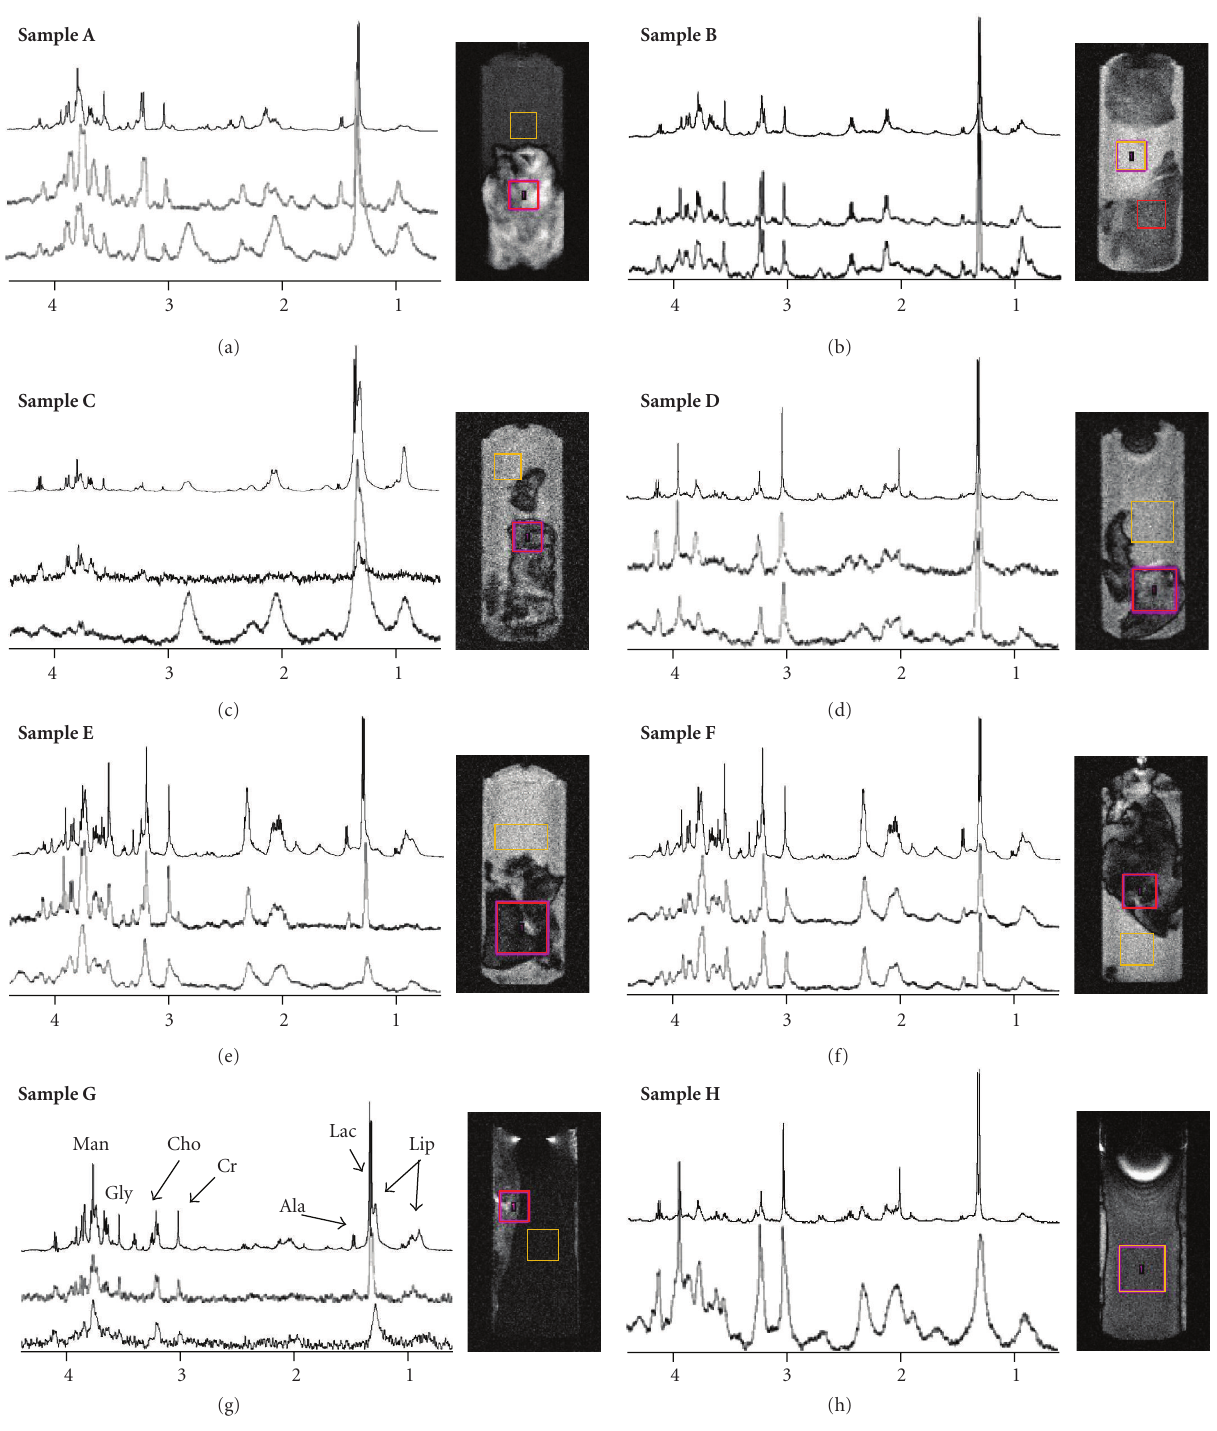
Figure 2: HRMAS CPMG (top) and MRM spectroscopy PRESS single-voxel spectra from solution (middle) and tissue (bottom) in each of the samples (A–H). MRM single-voxel location in tissue (red box) and solution (yellow box) is illustrated in the MRM images. Samples G and H were the only samples which underwent HRMAS experiments before MRM. Sample F underwent HRMAS study after MRM. The samples A–E underwent parallel study by HRMAS in other piece from the same biopsies. The resonances assigned in the CPMG HRMAS spectrum of sample G are: mannitol (Man), glycine (Gly), choline and phosphocholine (Cho), creatine (Cr), alanine (Ala), lactate (Lac), and lipids (Lip). For each sample, the MRM images shown are those that better illustrate the tissue shape and position inside the rotor. The MRM images shown for samples A and G belong to RARE sequences and the MRM images for samples B–F and H belong to MDEFT images. Moreover, the contrast in these MRM image was balanced to enhance the di ff erences between the tissue and the solution